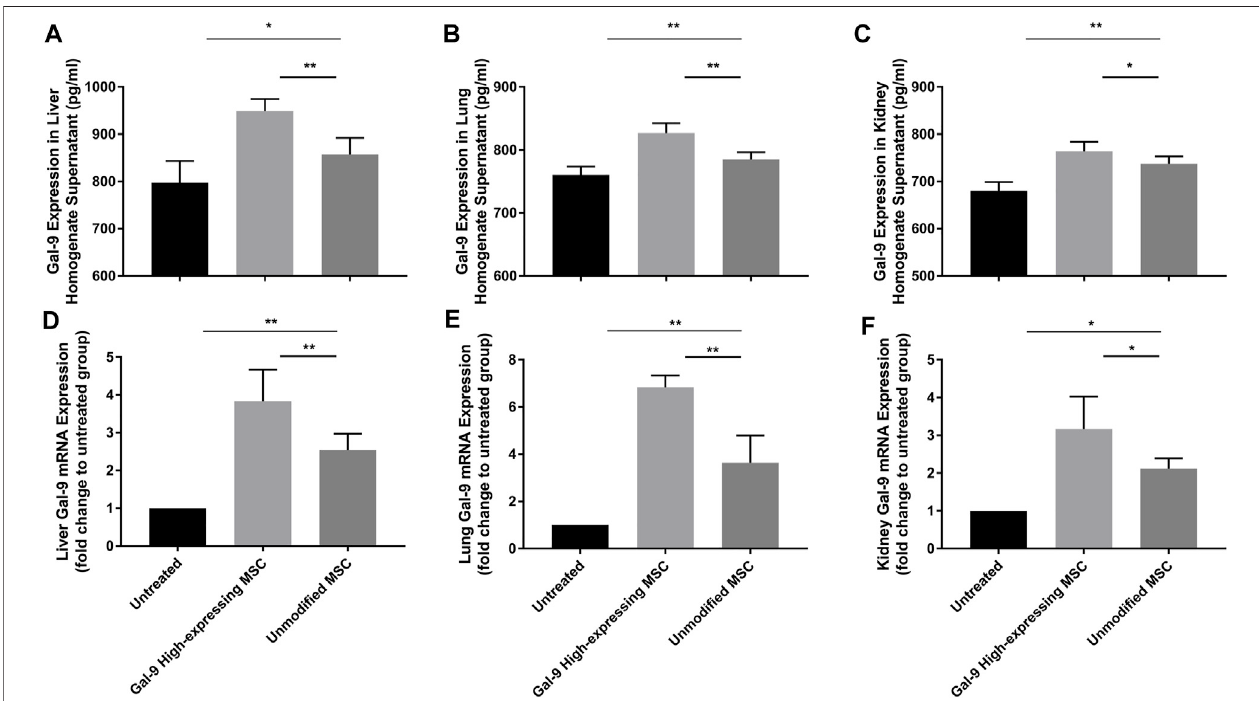
FIGURE7| Gal-9highly expresses inliver,lung, and kidney after Gal-9high-expressing MSCtreatment. (A – C) Gal-9 protein expression inthehomogenate ofliver (A) , lung (B), and kidney (C) , n = 6. (D – F) Relative Gal-9 mRNA expression levels in liver (D) , lung (E) , and kidney (F) , and n = 6. Data variance was assessed by using one-way analysis of variance (ANOVA), followed by least signi fi cant difference (LSD) test. * p < 0.05, ** p < 0.01.